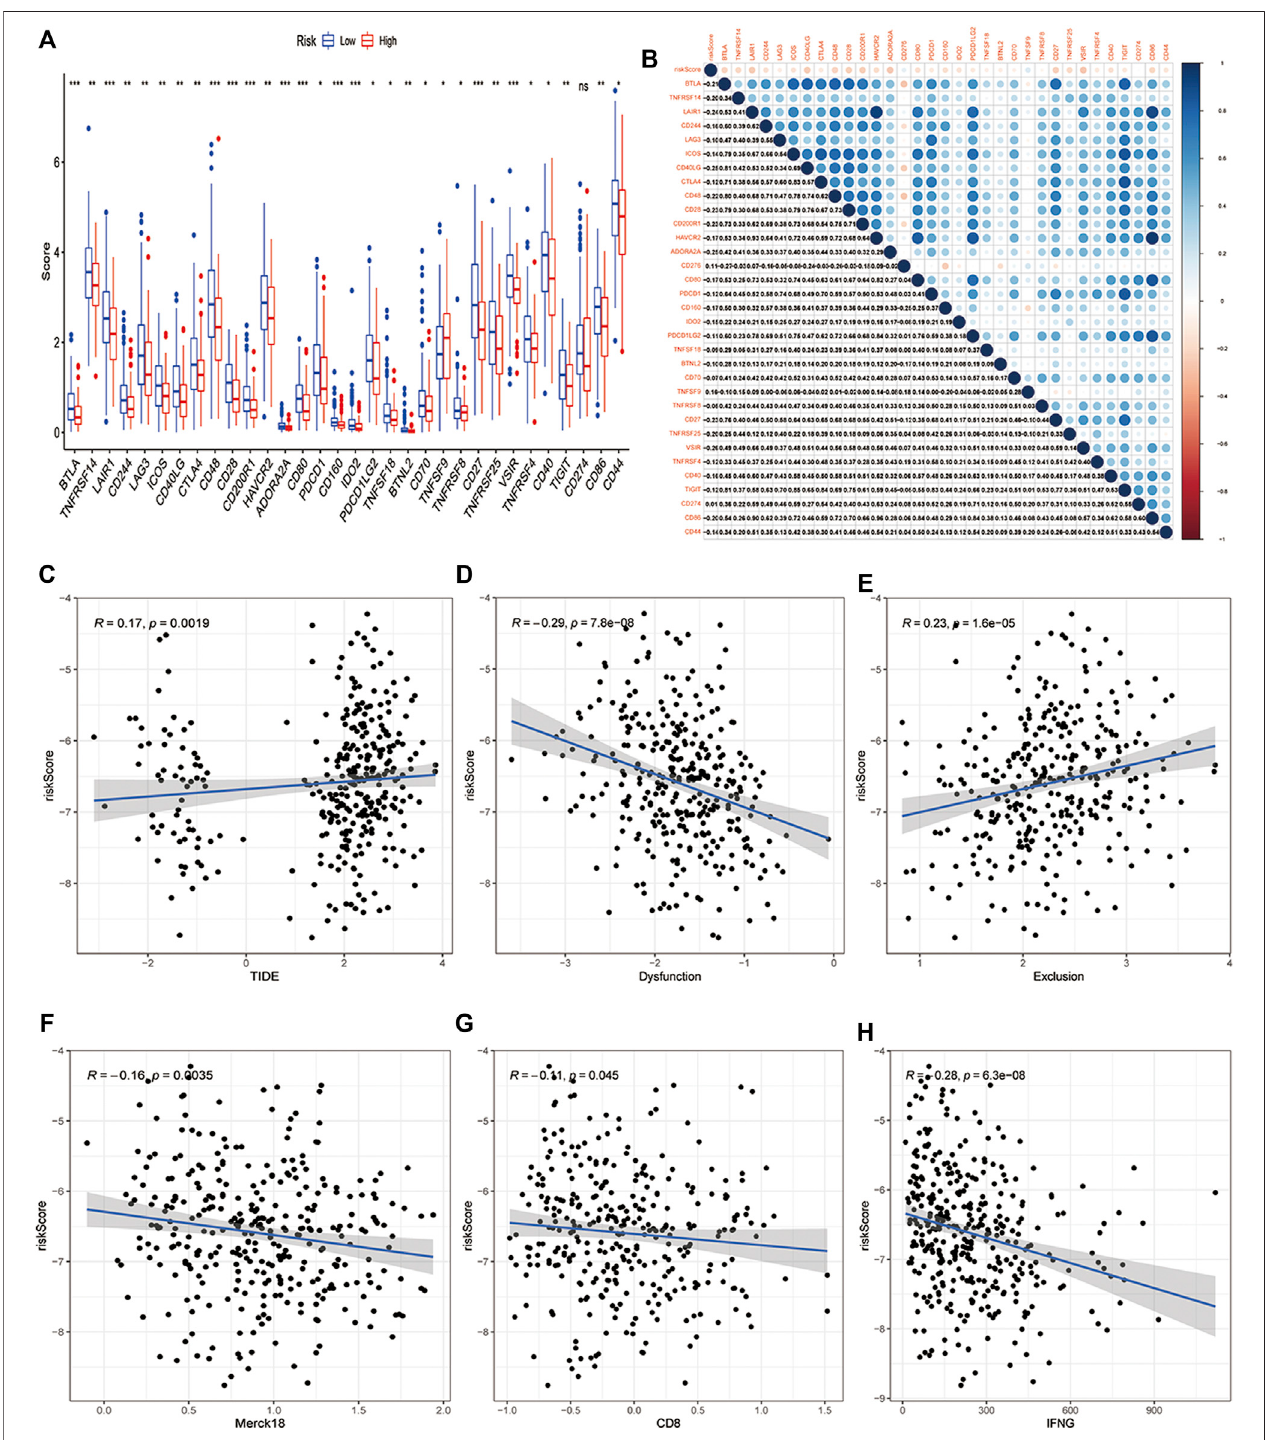
FIGURE 7 | Relationship between the PCD-related signature and biomarkers of immunotherapy. (A) Comparison of the immune checkpoints in high-risk and low-risk groups. (B) A correlogram was generated based on the Pearson p -value between risk score and immune checkpoints. (C) Correlation of risk score and TIDE score, (D) T cells dysfunction score, (E) T cells exclusion score, (F) Merck18 score, (G) CD8, (H) IFNG in high-risk and low-risk groups. (*, **, ***, and **** represent p < 0.05, p < 0.01, p < 0.001 and p < 0.0001, respectively).